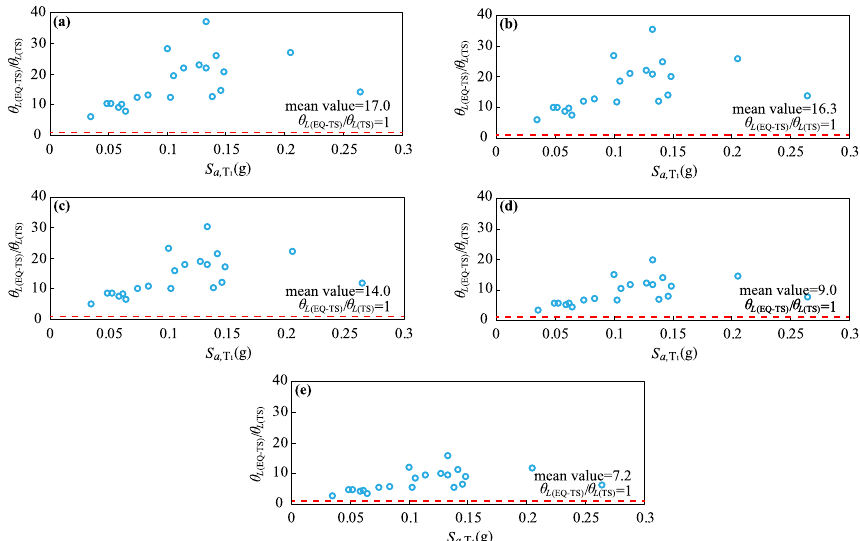
under the wave height (H) of: a 5 m, b 6 m, c 1